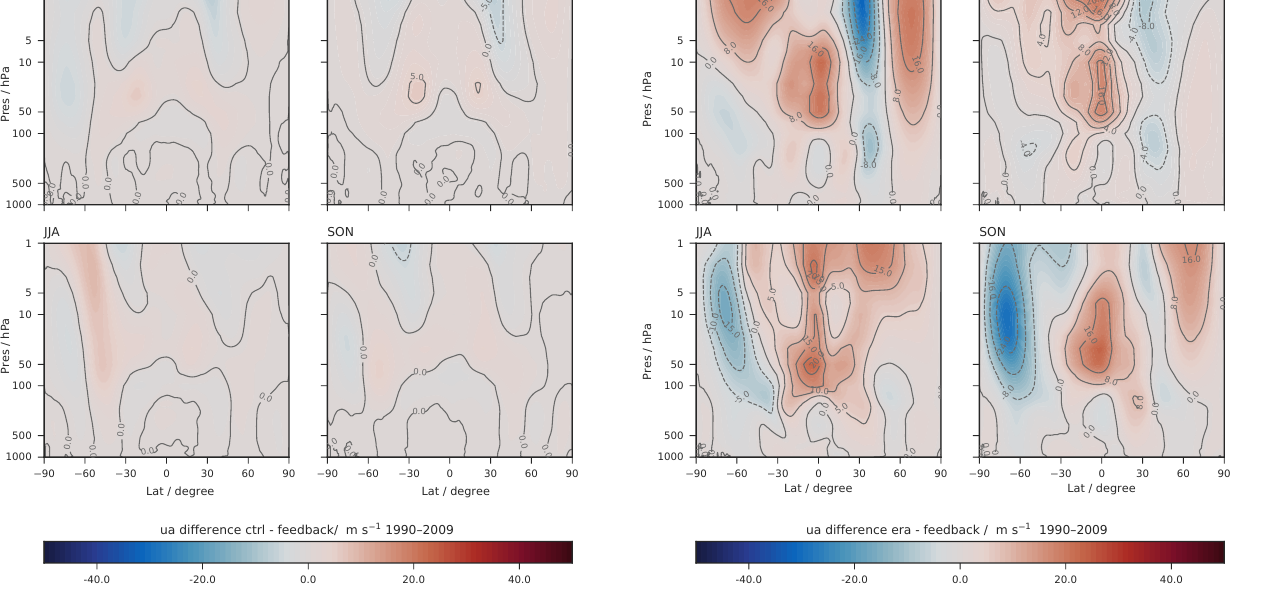
Figure 11. Latitude–height cross sections of seasonal and zonal mean zonal wind differences (ms − 1 ) for ICON-ART simulations from 1990 to 2009.